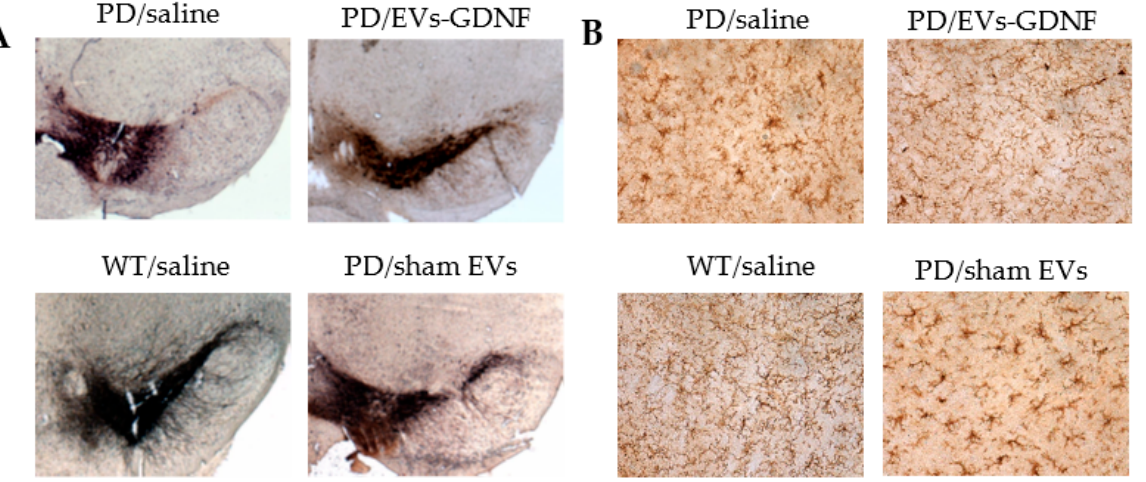
Figure 4. Neuroprotective and anti-inflammatory effects of EV-GDNF in Parkin Q311(X)A mice. Transgenic mice (4 mo old, n = 10) were i.n. injected with: saline (10 µL/mouse), EV-GDNF (3 × 10 9 particles/10 µL/mouse), or sham EVs (3 × 10 9 particles/10 µL/mouse). Wild-type control mice were intranasally injected with saline (10 µL/mouse). Animals were sacrificed at month 16, and brain slides were stained with TH, a marker for dopaminergic neurons ( A ); or Ab to CD11b for activated microglia ( B ). The images indicate significant preservation of TH-positive neurons and a decrease in microglial activation in Parkin Q311(X)A mice upon EV-GDNF treatment compared to PD mice treated with saline. The administration of sham EVs did not cause significant therapeutic effects.